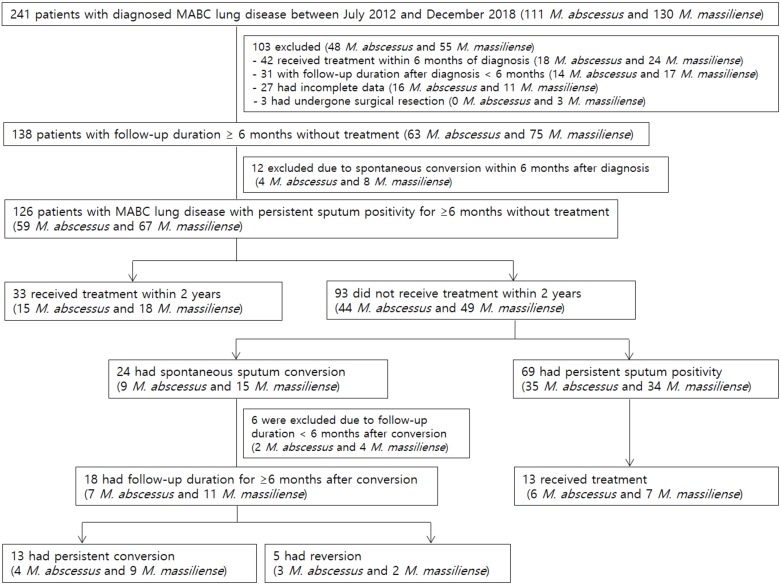
Study flow chart.MABC, Mycobacterium abscessus complex.